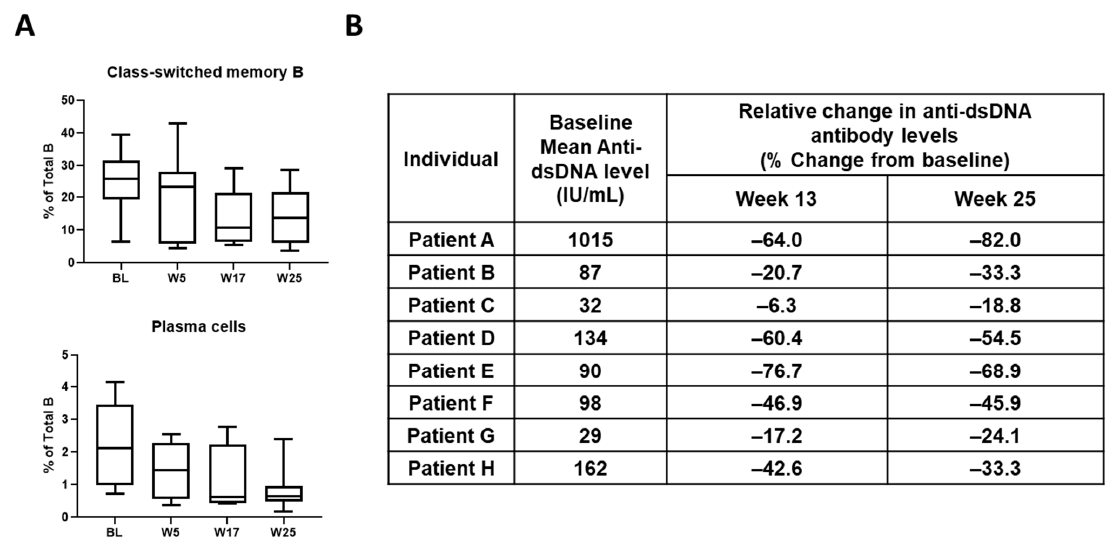
Figure 4. Biomarker Changes in Patients with SLE Treated with